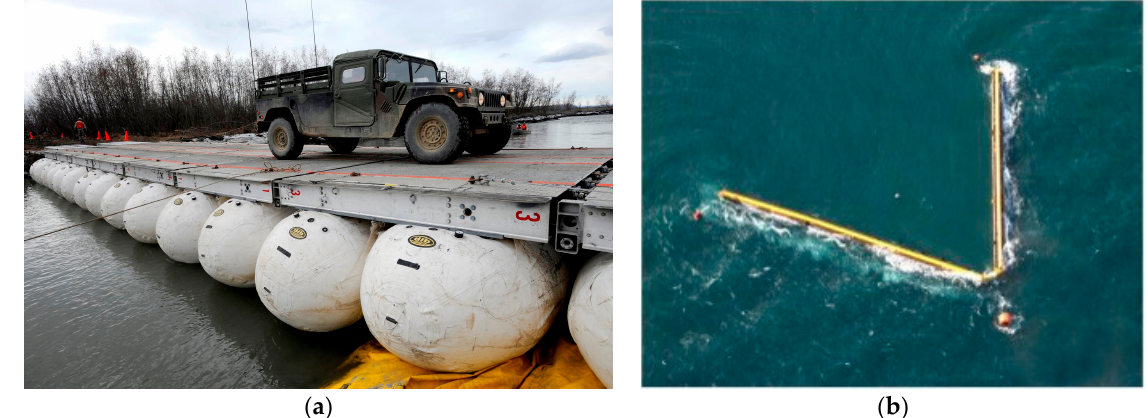
Figure 1. New-type floating inflated structures: ( a ) LMCS prototype; ( b ) RIB.